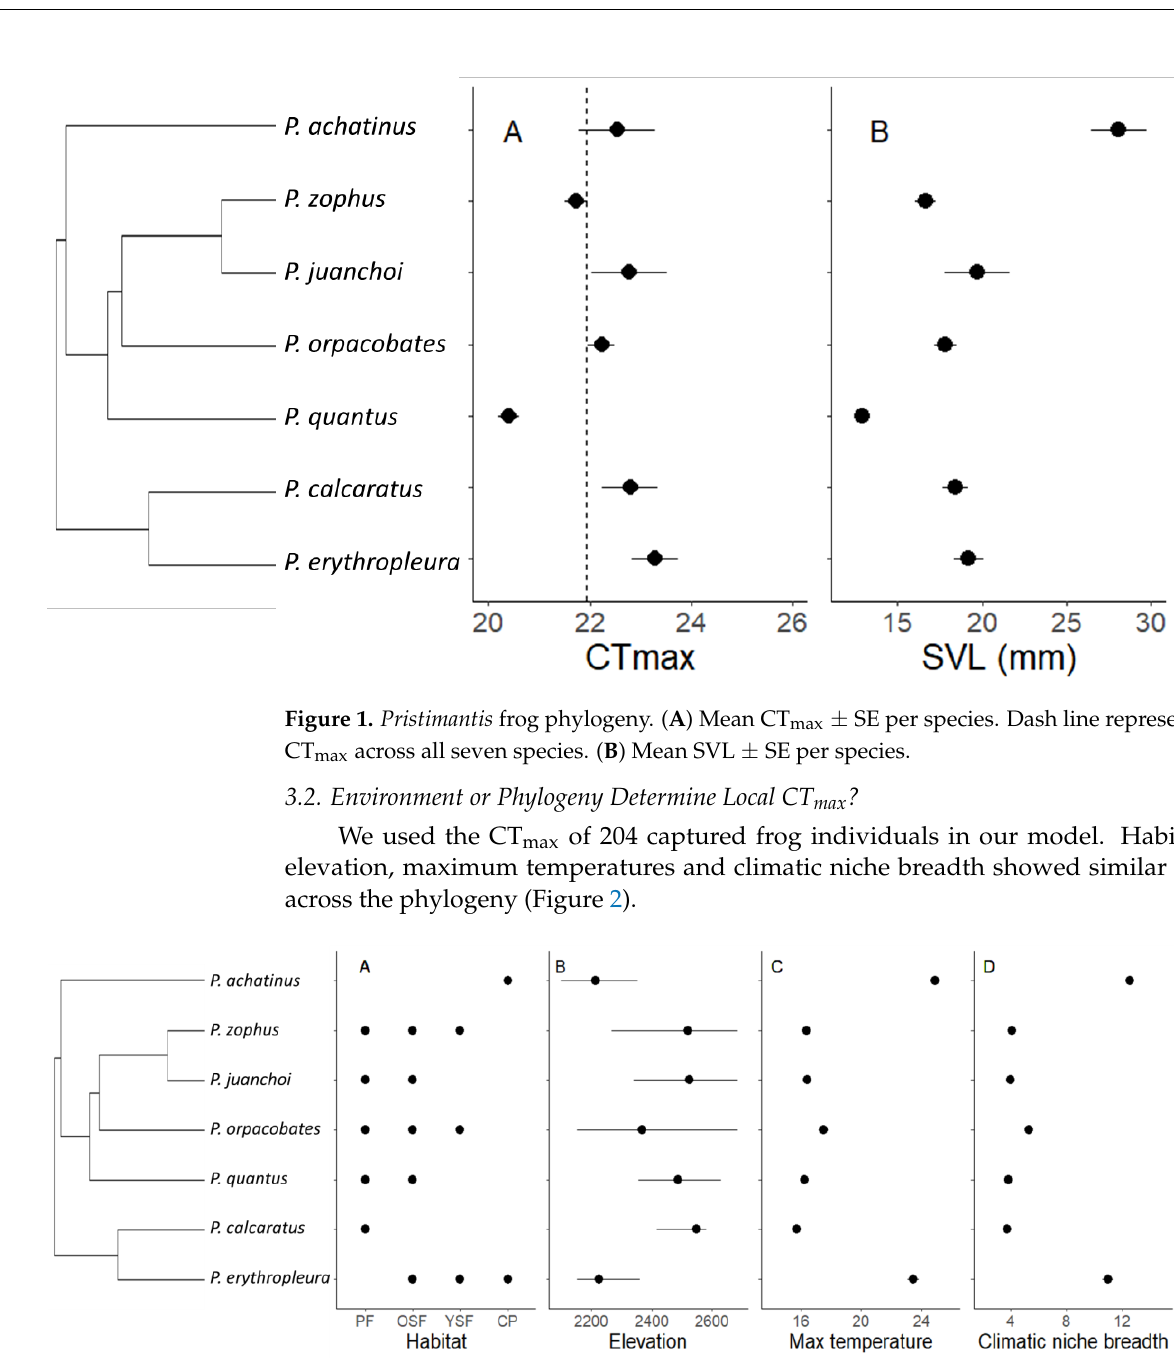
Figure 2. Pristimantis frog phylogeny and ( A ) their habitat (PF: primary forests; OSF: old secondary forests; YSF: young secondary forests; CP: cattle pasture), ( B ) mean (point), minimum and maximum (black line) elevation where they were collected, ( C ) mean ± SE daily maximum temperature they experience, and ( D ) mean ± SE climatic niche (calculated as maximum ambient temperature minus minimum ambient temperature).